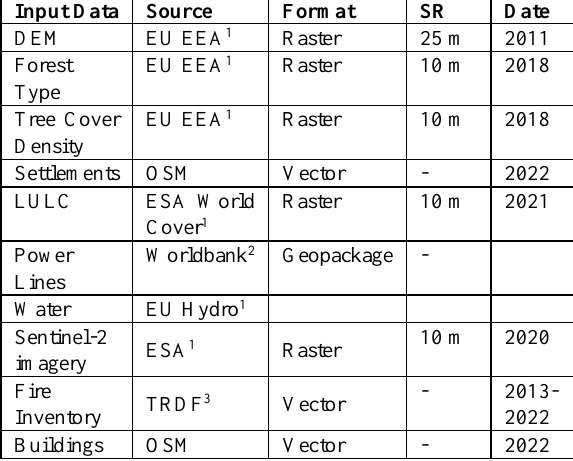
Figure 5 . The distribution of training and test